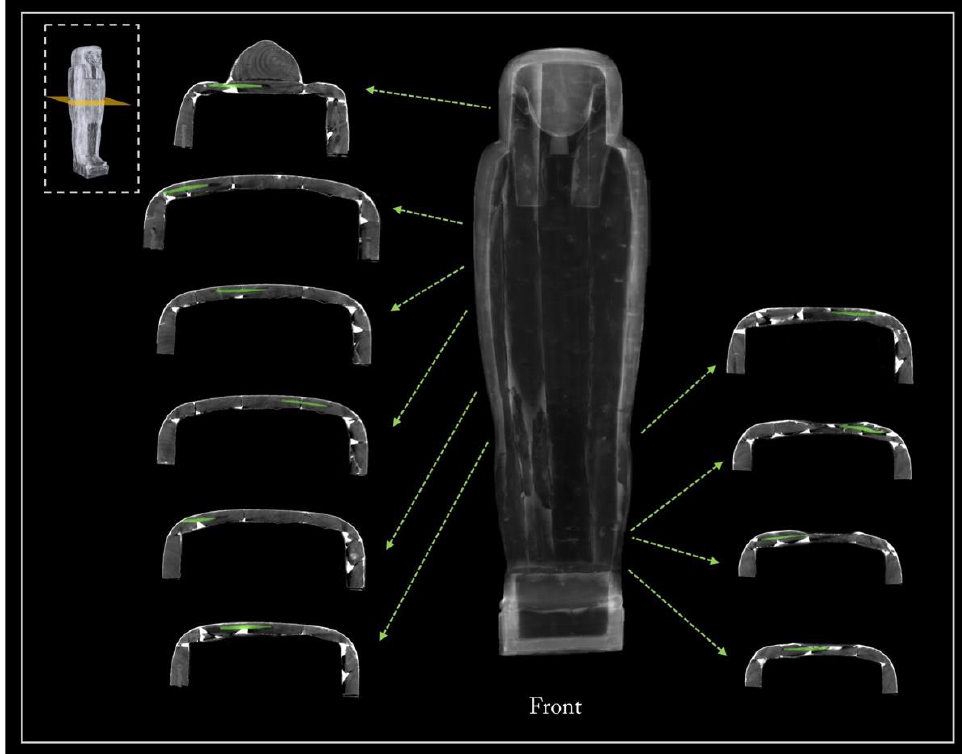
Figure 7. 3D rendering of the front of the lid: in green, the numerous dowels joining the four planks.